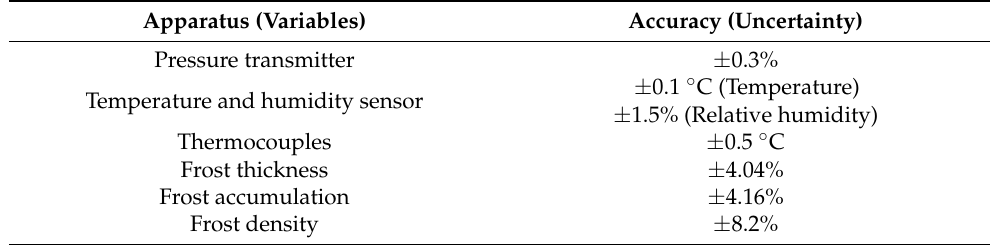
Table 1. Uncertainty of measured and calculated